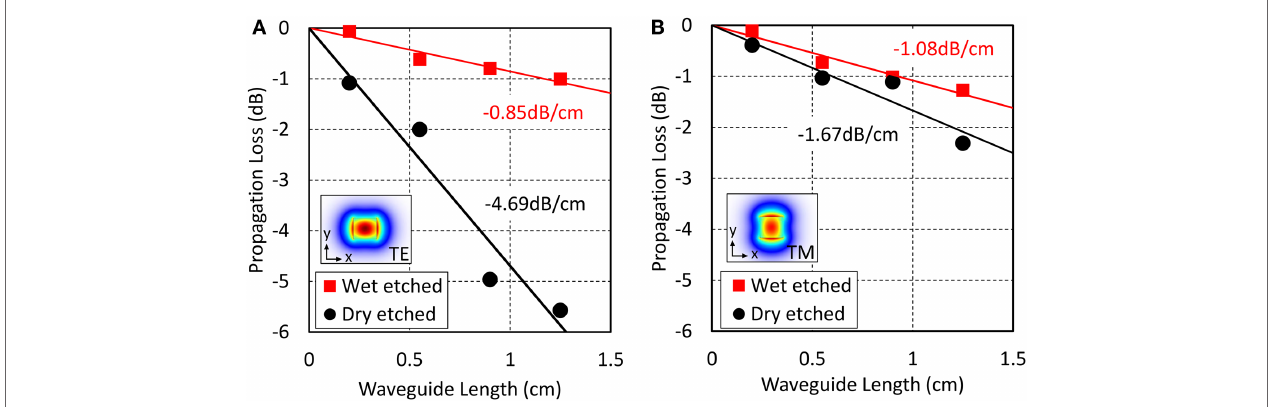
FigUre 4 | (a) TE polarization: normalized transmission of the fabricated waveguides using wet etching (red squares) and dry etching (black circles) techniques. The transmission of the wet etched and dry etched waveguides were normalized relative to − 15.68 and − 16.41 dB, respectively, which corresponds to the setup and grating coupler losses. (B) TM polarization: normalized transmission of the fabricated waveguides using wet etching (red squares) and dry etching (black circles) techniques. The transmission of the wet etched and dry etched waveguides were normalized relative to − 20.78 and − 20.67 dB, respectively. The insets show the mode profiles of the TE and TM modes. We measured the minimum propagation loss of 0.85 dB/cm for TE polarization and 1.08 dB/cm for TM polarization for wet etched